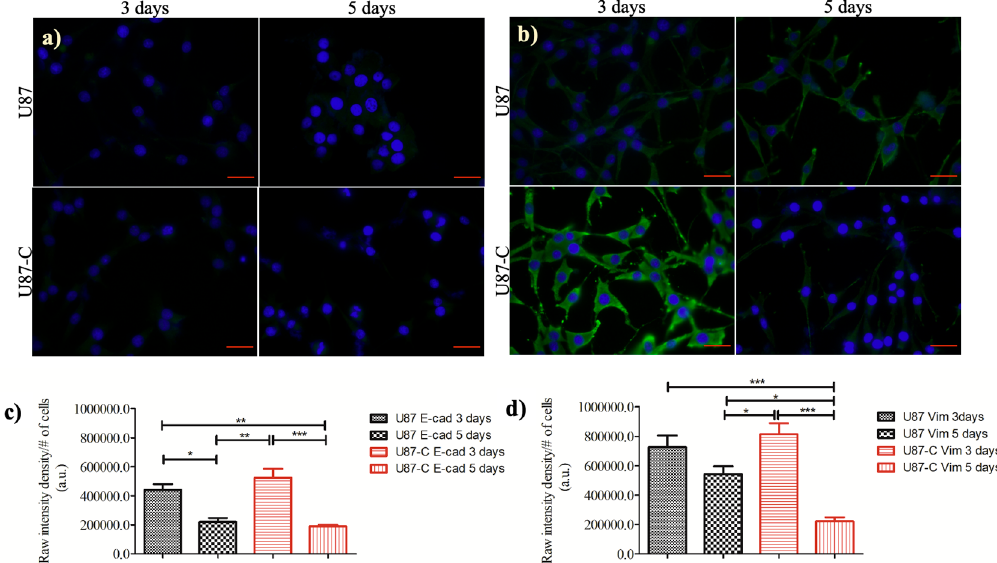
Figure 7. Comparisons of E-cadherin and Vimentin expressions. ( a ) Immunofluorescence staining of E-cadherin (E-cad), ( b ) Vimentin (Vim) proteins (green) with nuclei counterstained (blue) by DAPI. The scale bar is 25 µ m, the magnification is x63. Quantification of ( c ) E-cadherin and ( d ) Vimentin expressions of U87 and U87-C glioma cells for 3 and 5 days. The one-way analysis of variance Tukey’s multiple comparison test was applied. *, **, and *** denotes for p < 0.05, 0.01, and p < 0.0001,